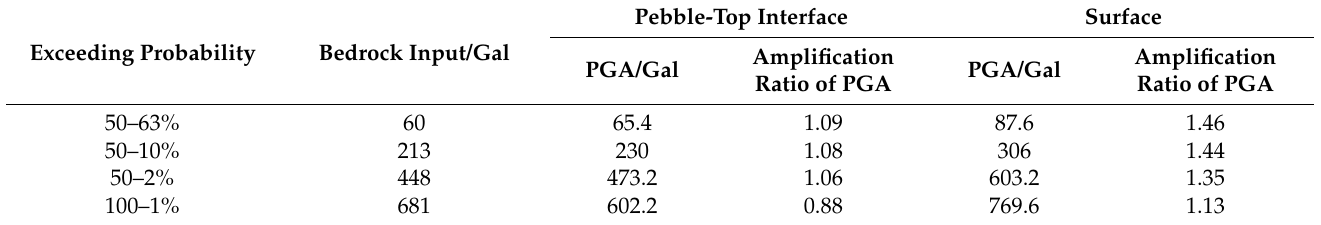
Table 6. Comparison table of amplification ratio of PGA between pebble-top interface and ground